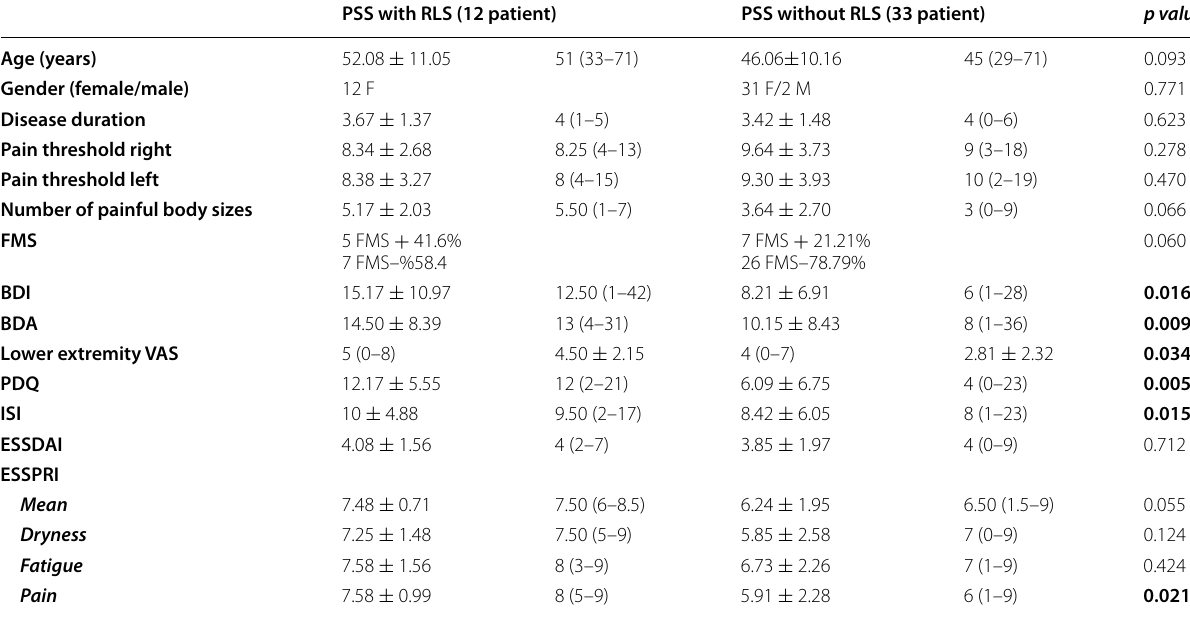
Table 2 Comparison of data with and without RLS in patients with PSS